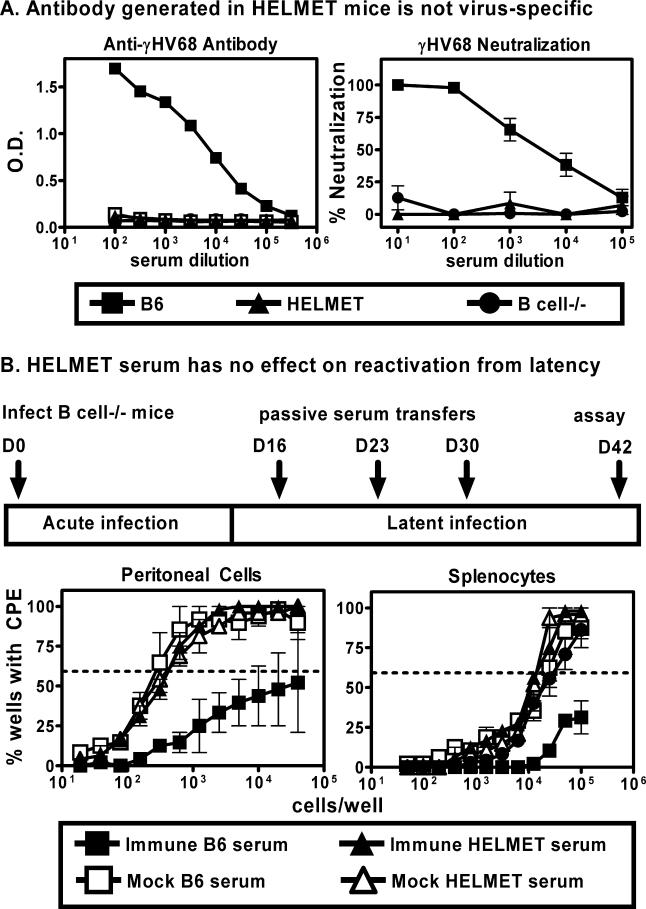
Control of γHV68 Latency by HEL-Specific B Cells Is Not due to Production of Cross-Reactive Antibody(A) (Left) ELISA for γHV68-specific antibodies in serum from mock infected and virus infected B6, HELMET, and B cell−/− mice. Data are representative of two independent experiments. (Right) Sera from mock infected and γHV68 infected B6, HELMET, and B cell−/− mice were incubated with γHV68 and tested for their ability to neutralize γHV68 infection. Percent neutralization was normalized to results obtained using serum from mock-infected mice of the same genotype.(B) Beginning at day 16 post-infection, B cell−/− mice were treated with serum from mock infected or γHV68 infected B6 and HELMET mice. Ex vivo reactivation from latency was assessed 42 d after infection.